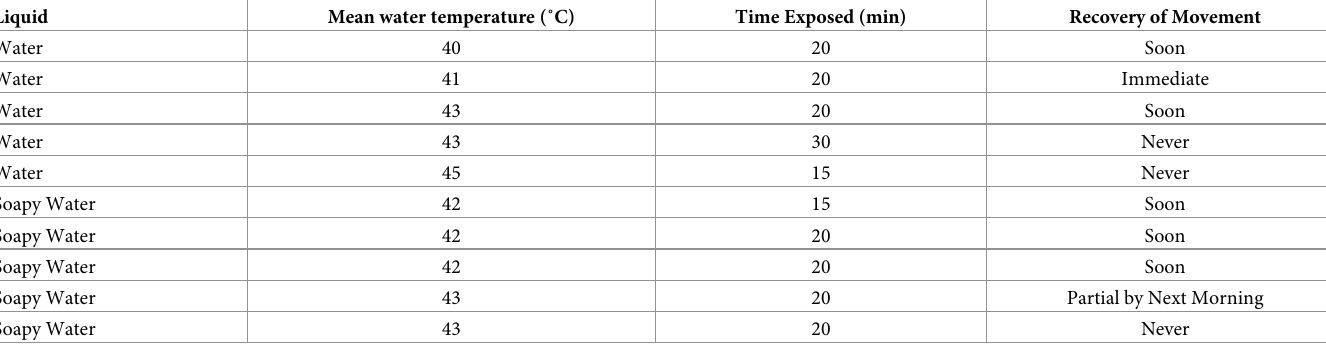
Each line represents two ticks, one of each sex, both of which recovered at the same rate. “Soon” means full recovery within 10–60 min. “Never” means no recovery by the next